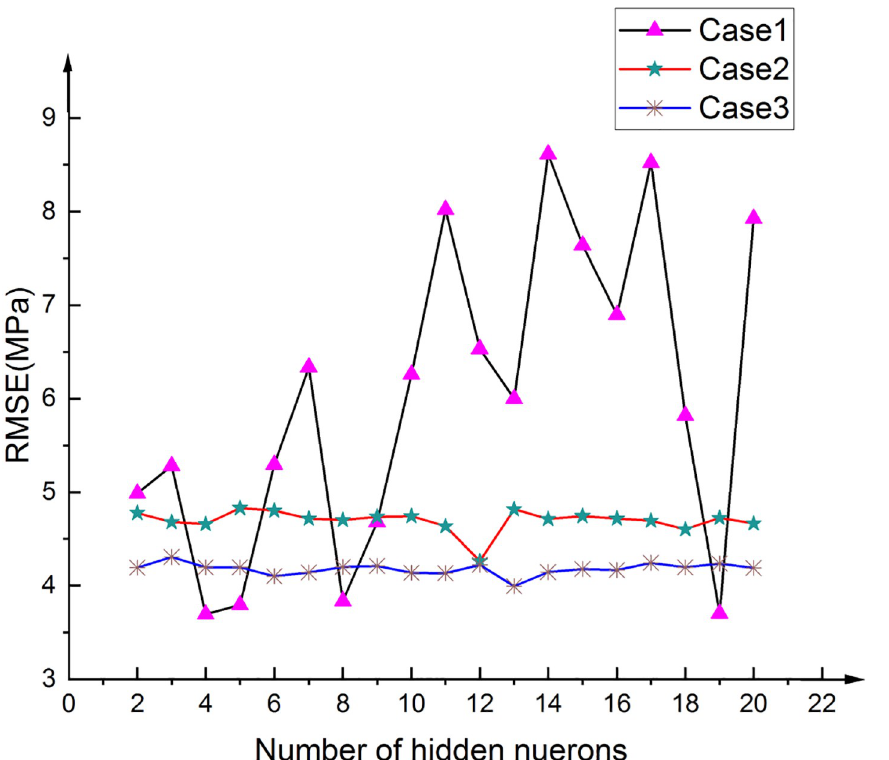
Fig 16. Variation in the RMSE with the number of hidden